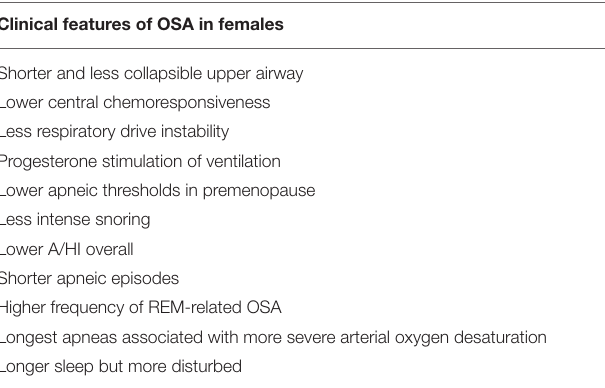
TABLE 1 | Clinical features of obstructive sleep apnea (OSA) in females. Clinical features of OSA in